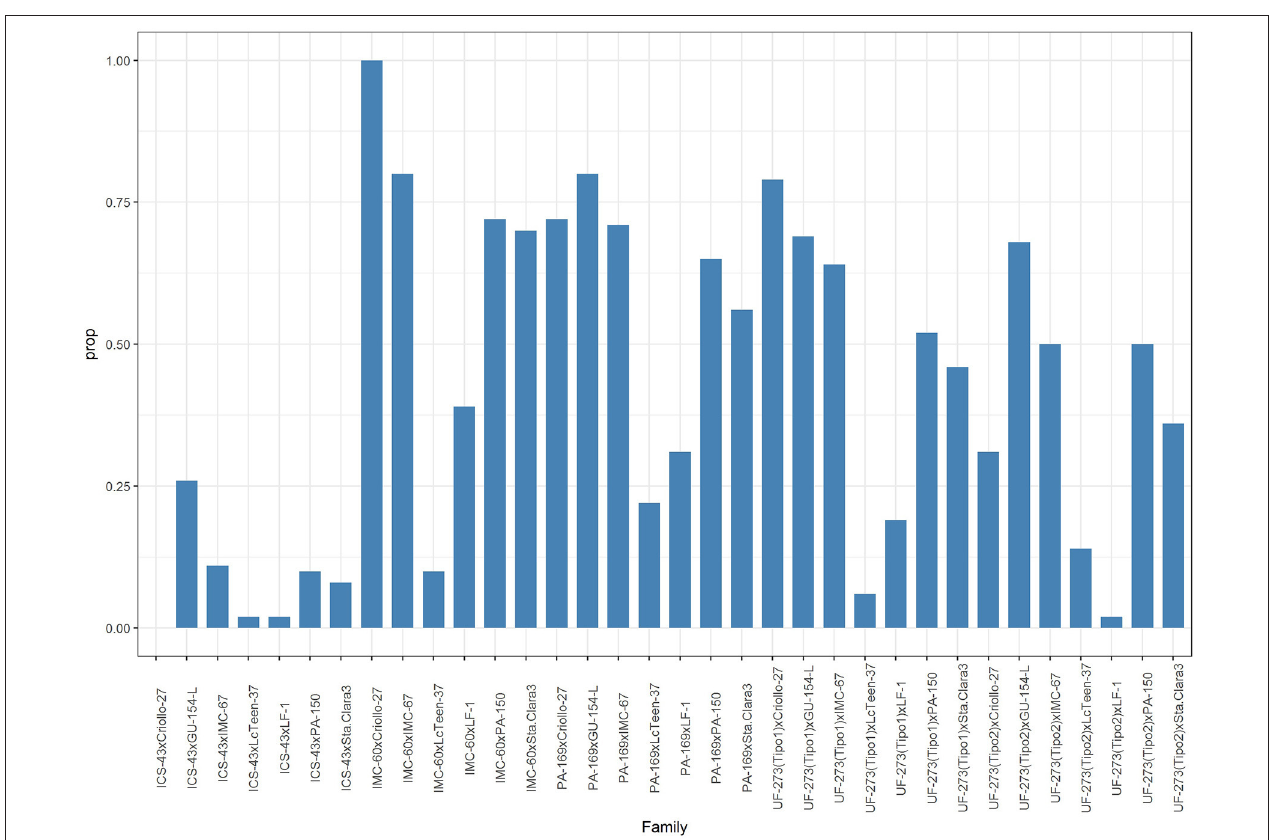
FIGURE 9 | Proportion of individuals within a family greater than the average predicted value of the parents for